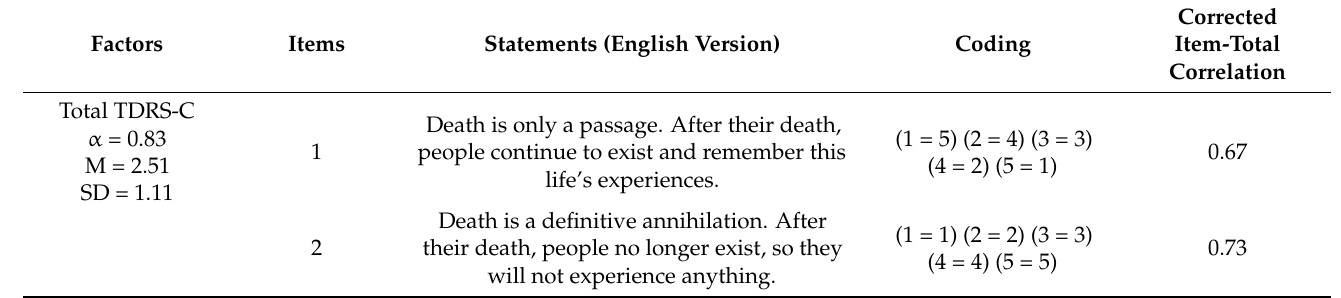
Table 2. Reliability of Testoni Death Representation Scale for Children (TDRS-C) 1